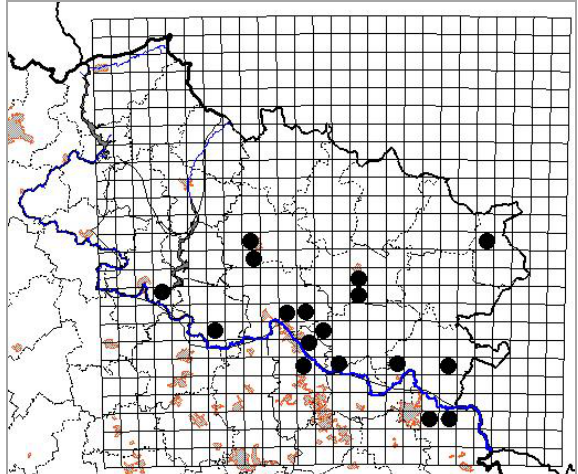
Fig. 15. The map of the distribution of Coniza canadensis L. in the Starobilsk grass-meadow